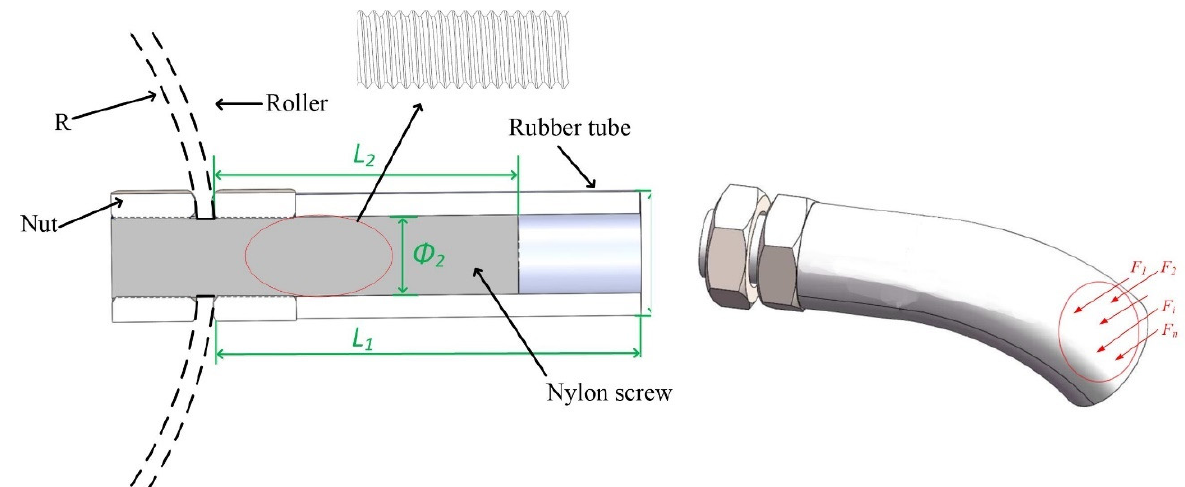
Figure 9. Right flexible